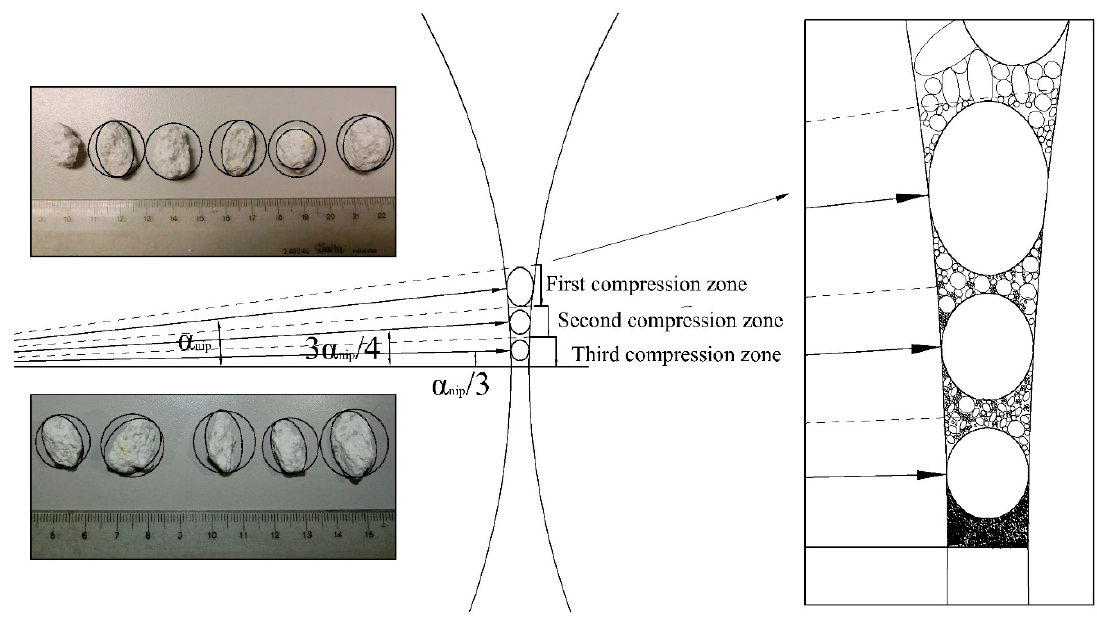
Figure 9. Particles of the altered granite presented an ellipsoid shape, being classified as a larger top-size but with the ability to sneak between the rolls. Using the breakage distribution function as an evaluator, three stages were necessary for the particles to be ground into a size smaller than the gap and subsequently released as a product.